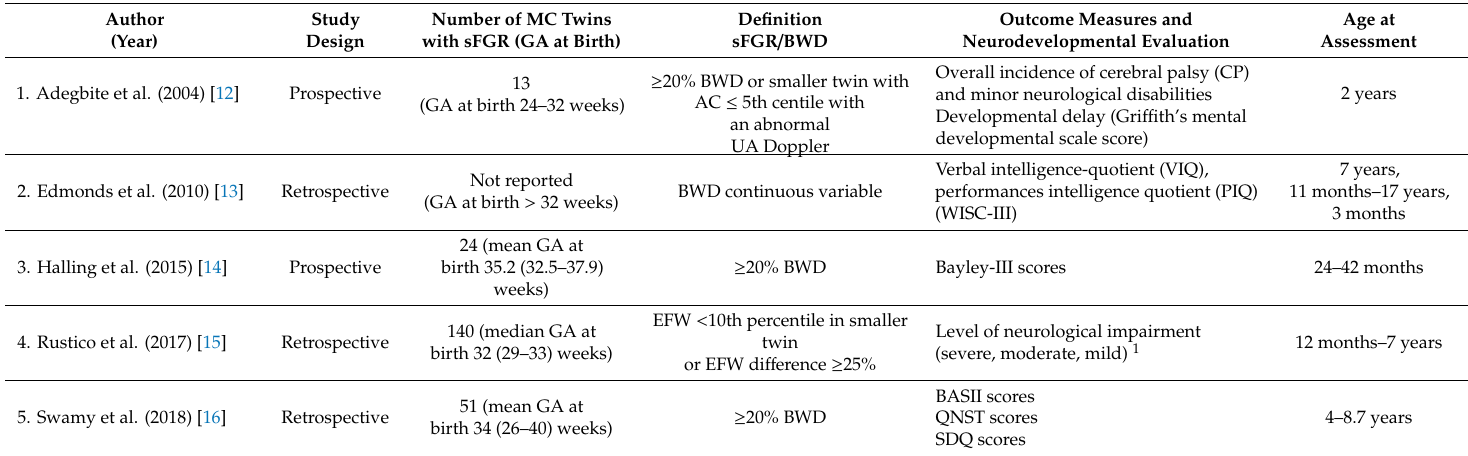
Table 1. Summary of study characteristics of the included